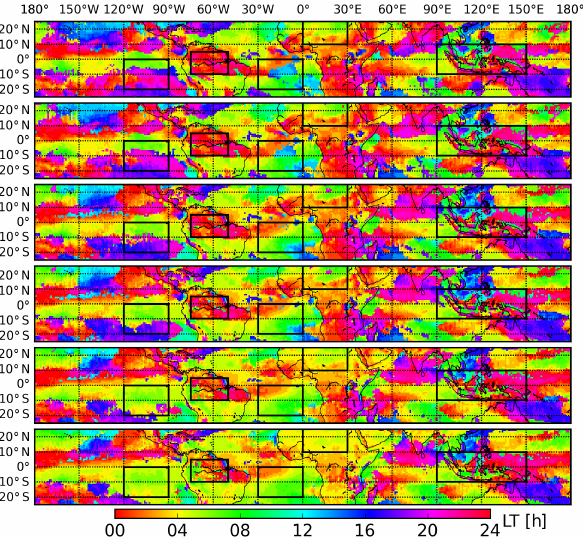
Figure 13. Diurnal peak time in local time for RH I based on Fourier series fit. Depicts from top to bottom are for SAPHIR channels 1–6, respectively.